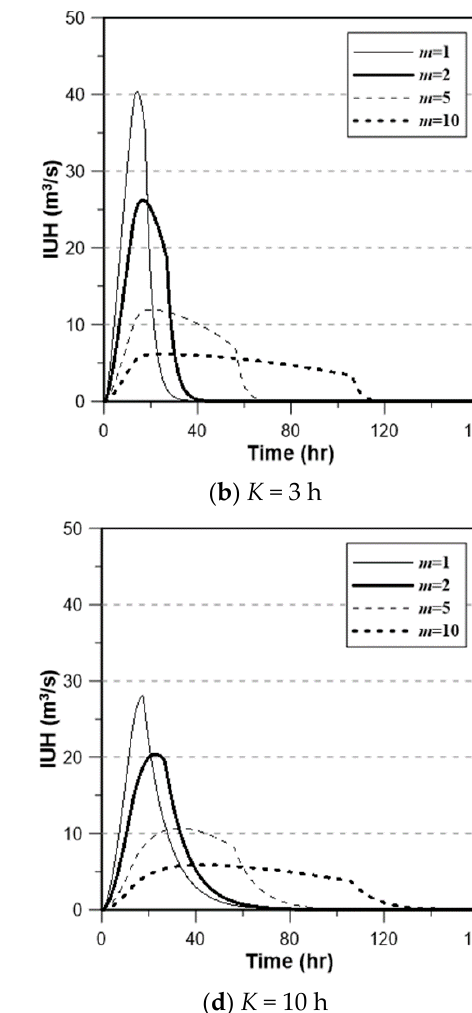
Figure 2. Clark’s IUHs derived for an elliptical basin with its area of 188.50 km 2 and the channel velocity of 1 km/h for various values of m of the case that the storage coefficients ( K ) = 1 h ( a ); K = 3 h ( b ); K = 5 h ( c ); and K = 10 h ( d ).